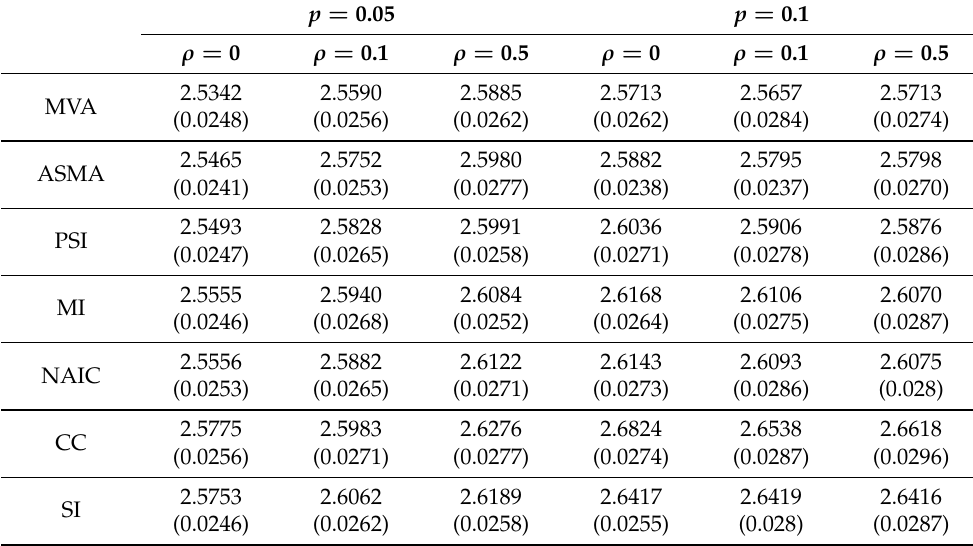
Table A1. MSE and its standard error, averaged over 100 simulated datasets. p = 0.05 p =